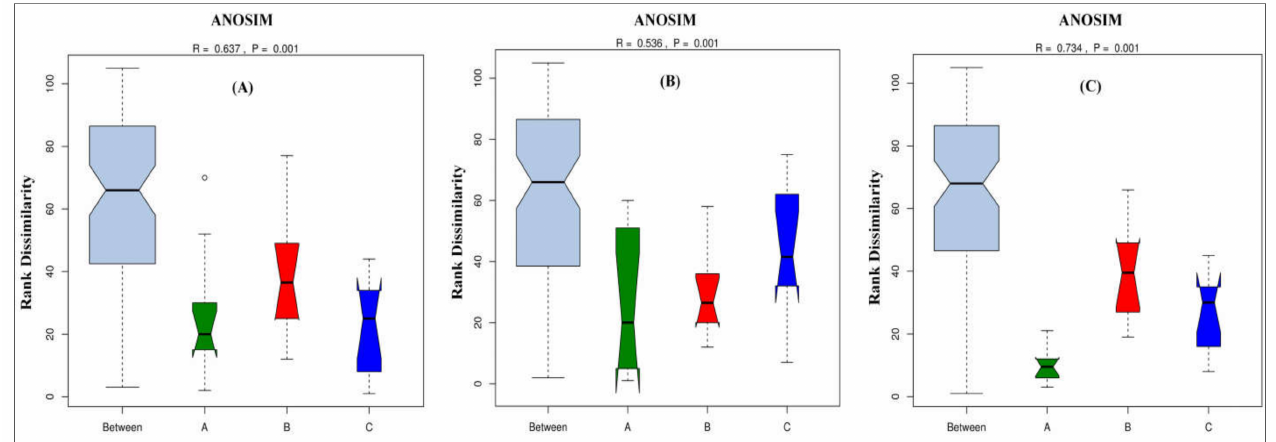
Figure 8. Anosim analysis of ( A ) leaf, ( B ) stem, and ( C ) root. Anosim analysis is used to determine whether a group is meaningful by determining whether differences between groups are significantly greater than intra-group differences. If the R-value is greater than 0, the difference between the groups is greater than the intra-group difference, and the grouping is more reasonable. If the R-value is less than 0, the difference between the groups is smaller than the intra-group difference, and the group is defective. The greater the p -value, the greater the difference between